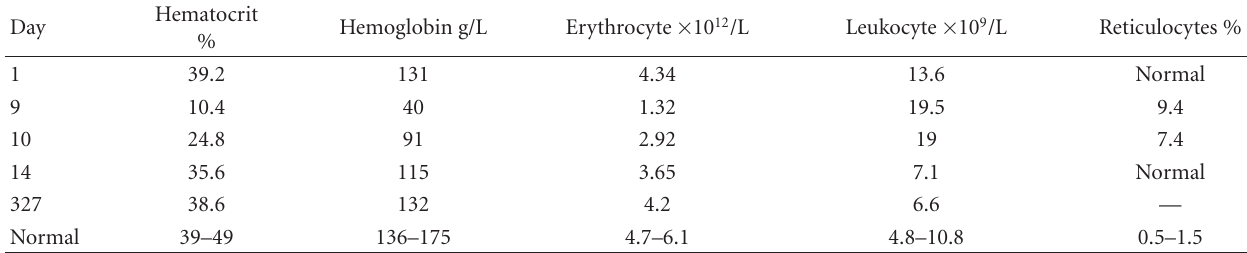
Table 1: Hematological parameters in the patient with severe piperacillin-induced immune hemolytic